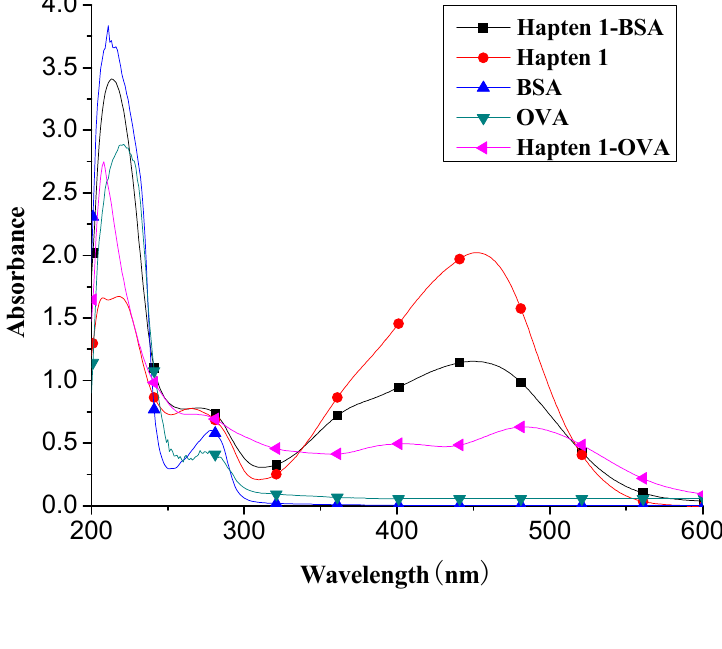
Figure 2. UV spectra of BSA, OVA, Hapten 1, Hapten 1-BSA and Hapten